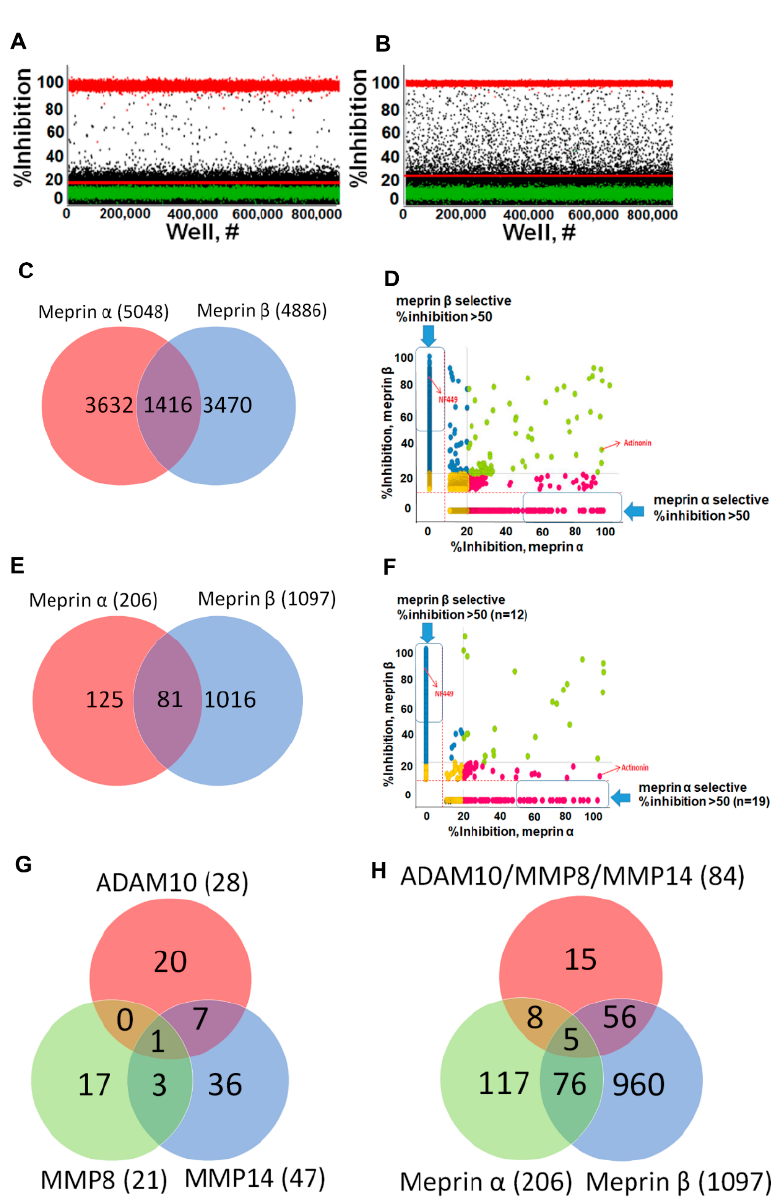
Figure 5. Primary uHTS campaigns. Scatter plots of ( A ) meprin α and ( B ) meprin β primary campaigns. Overall, >650,000 compounds were screened in singlicate against each target. ( C ) Venn diagram of meprin α and meprin β uHTS hits shows 1416 nonselective hits, 3632 meprin α and 3470 meprin β nominally selective hits. ( D ) Correlation plot of meprin α and meprin β actives demonstrates distribution of hits. ( E ) Venn diagram of meprin α and meprin β confirmation assays shows confirmed 81 confirmed nonselective hits, 125 meprin α and 1016 meprin β confirmed selective hits. Each confirmation assay was performed in triplicate. ( F ) Correlation plot of meprin α and meprin β actives demonstrates distribution of hits. ( G ) Venn diagram of meprin α and β hits screen against the counter targets MMP-8, MMP-14, and ADAM10. The 84 meprin actives inhibited one of three counter targets. ( H ) Venn diagram of meprin α and β hits versus three combined counter targets. A total of 117 compounds selectively inhibited meprin α while 960 compounds selectively inhibited meprin β